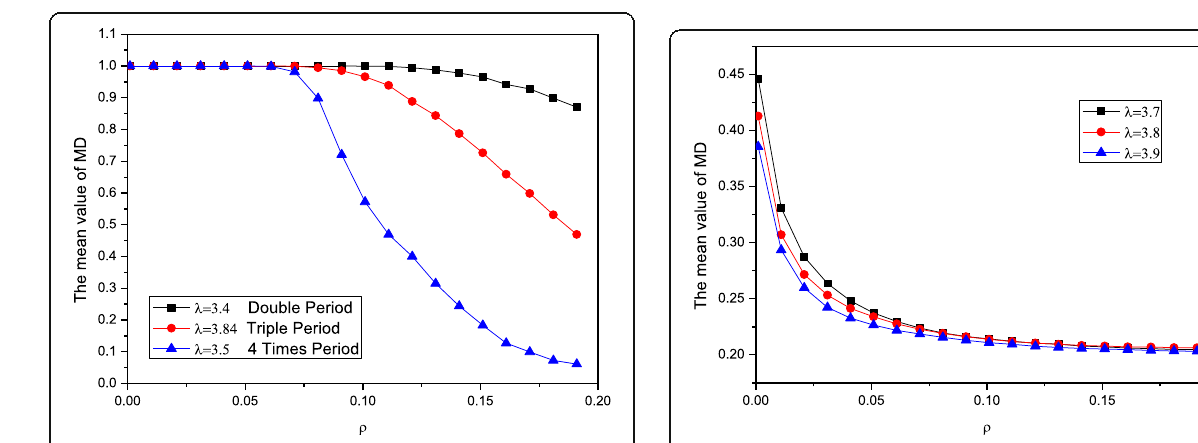
data. With the increase of noise, these curves decrease monotonously. The position of the curve in the figure is related to the complexity of the corresponding